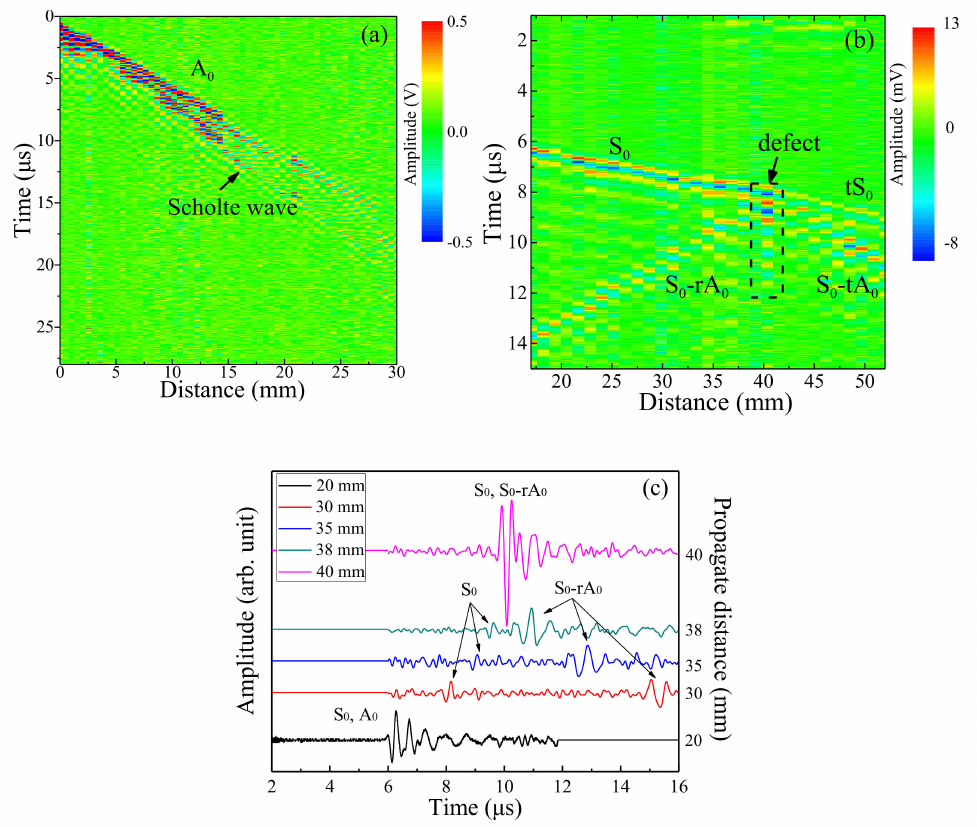
Figure 5. ( a ) B-scan image using the top generation configuration on the underwater plate; ( b ) B-scan image of lateral generation configuration in the underwater plate; ( c ) time domain signal of different positions using the lateral generation